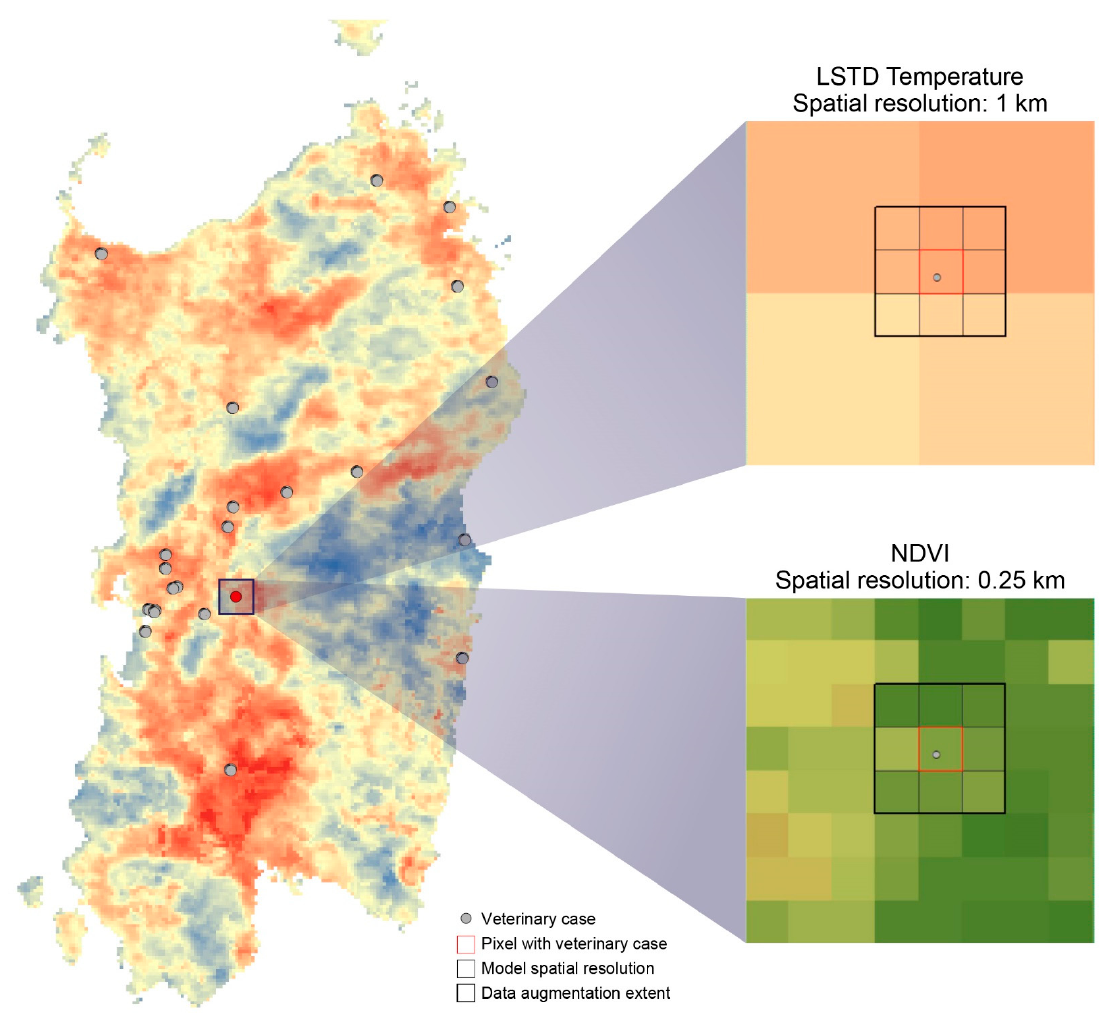
Figure 5. Spatial scheme of data augmentation: the status of the pixel with WNV circulation, has been replicated to the 8 neighbouring boundary pixels, resulting in a group of nine pixels having the same status in a specific 16 days raster and di ff erent environmental conditions of the predictors.